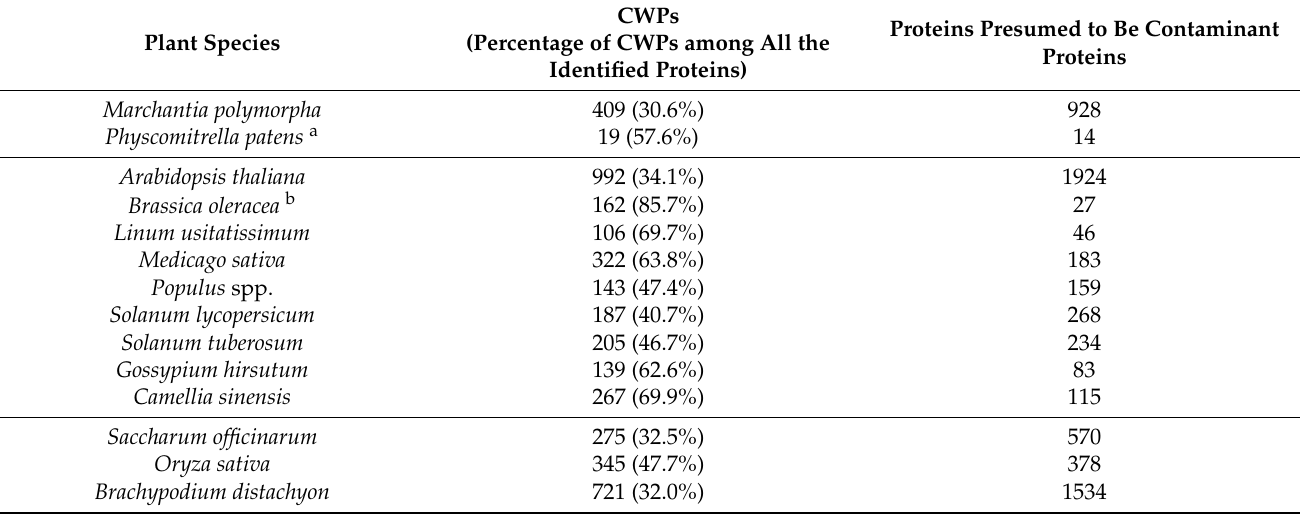
Table 2. An overview of the proteins present in WallProtDB-2